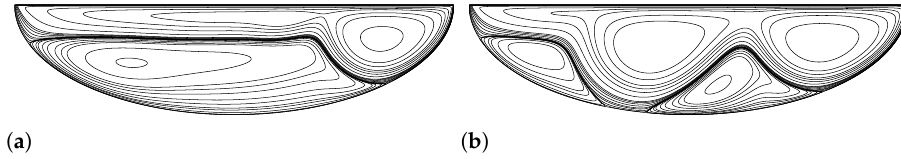
Figure 4. Bifurcation of the solution in driven semi-elliptical cavity flow with D = 0.5 aspect ratio. ( a ) Re = 5058 (1st solution). ( b ) Re = 5059 (2nd solution).